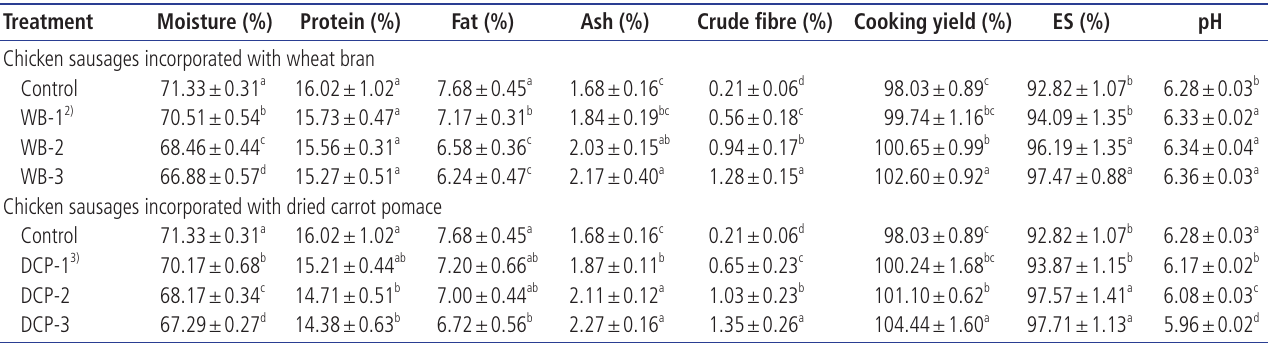
Table 2. Proximate and physico-chemical properties of chicken sausages incorporated with different levels of wheat bran and dried carrot pomace 1)